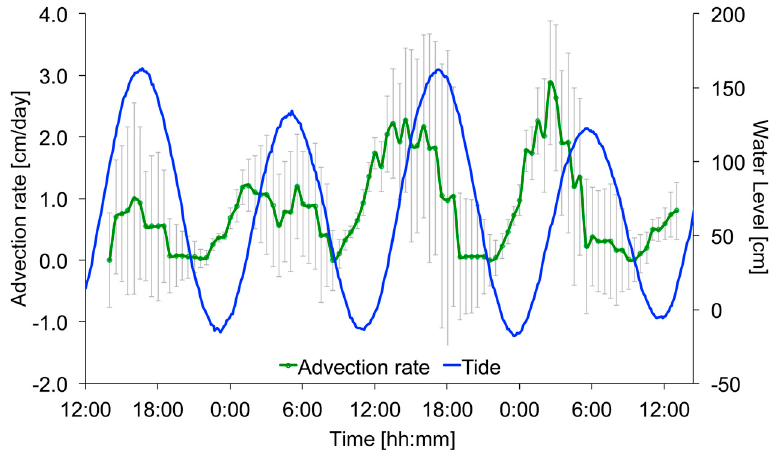
Figure 6. Time series showing ocean water levels (tides, in blue) and the computed submarine groundwater discharge (SGD, in green) advection rates. The error bars denote ± 1 standard deviation.